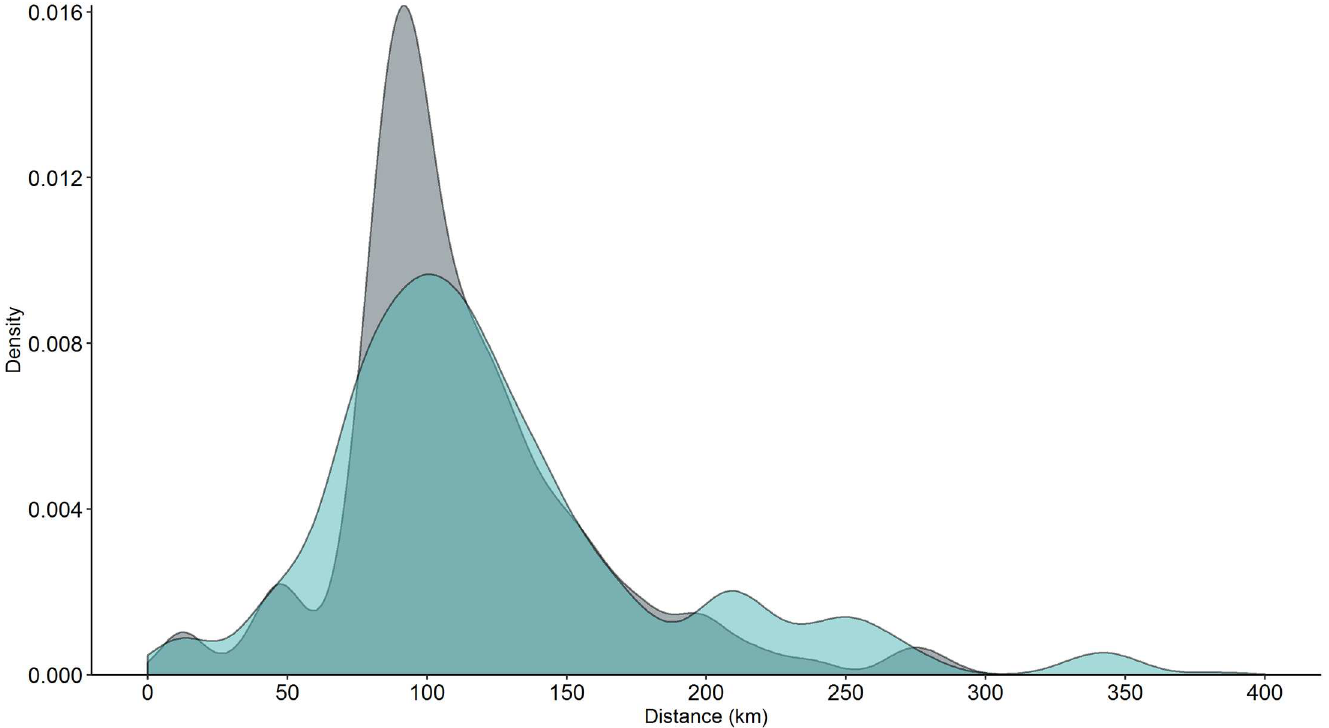
Fig 5. Density kernel for dispersal distance from source site for all islands for the five-yearmodel run. Green kernel denotesMay-June spawning and gray kernel